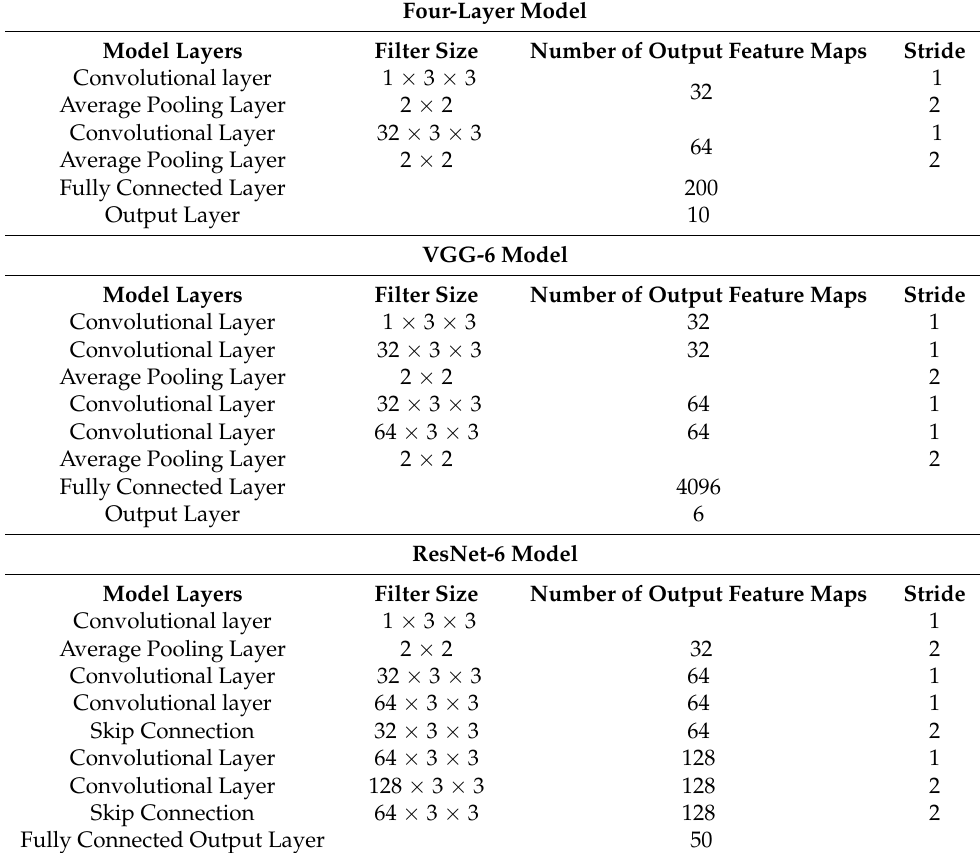
Table 3. Proposed DCSNN models for MNIST, KITTI and License plate